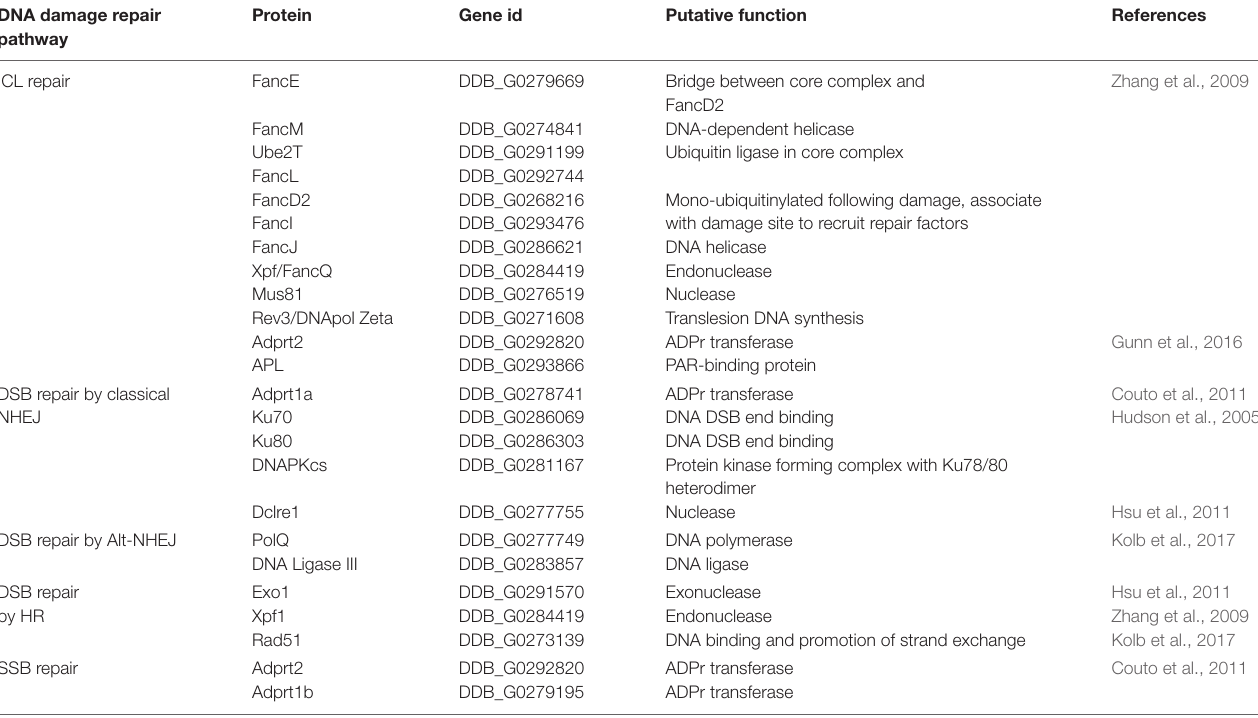
TABLE 1 | DNA repair factors experimentally verified to have a role in repair of interstrand cross links, double and single strand DNA breaks in D. discoideum . DNA damage repair